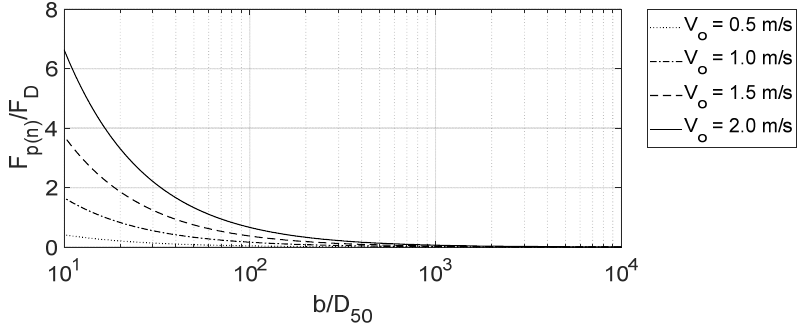
θ = 0 and R = 2 for various values of V o